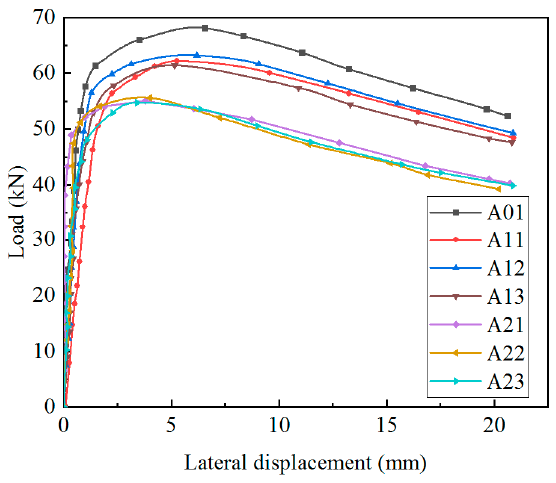
Figure 13. Load–lateral displacement curves of the corroded steel beams.